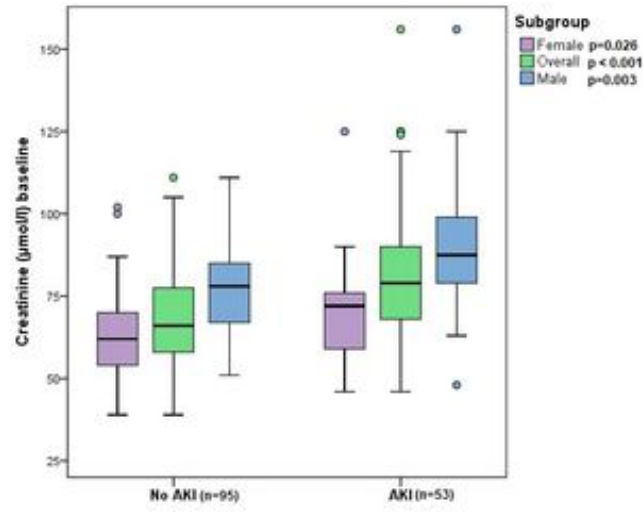
Fig. Correlation of baseline creatinine with AKI development stratified by